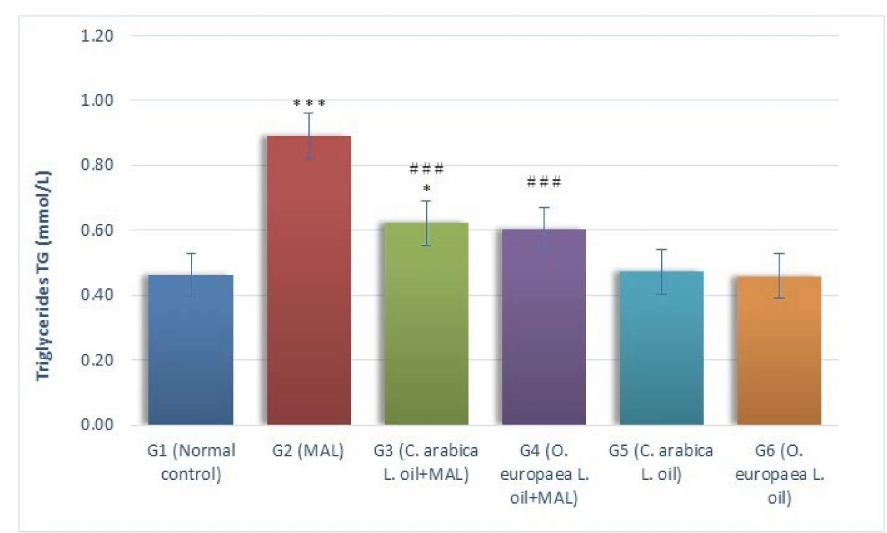
Figure 1. Influence of Coffea arabica L. oil and Olea europaea L. oil on the serum triglyceride levels. When a comparison was made against the normal control group, a significant difference was found in the mean values at p ≤ 0.05 *; p ≤ 0.001 ***. When a comparison was made against the MAL- intoxicated rats, a significant difference was found in the mean values at p ≤ 0.001 ### . The serum cholesterol (mmol/L) levels considerably ( p ≤ 0.001) increased as a result of MAL intoxication in the G2 group when a comparison was made with the G1 group of rats (normal control). Furthermore, while comparing it with the G1 group (normal control G1), the serum cholesterol levels considerably ( p ≤ 0.001) increased when the MAL-poisoned rats were daily fed with the oils of Coffea arabica L. (G3) and Olea europaea L. (G4) in the measures of 400 mg/kg BW, alternatively, as compared to the MAL-intoxicated G2 rats, the serum levels of cholesterol significantly decreased in MAL-poisoned rats when fed with the oils of Coffea arabica L. (G3: p ≤ 0.01) and Olea europaea L. (G4: p ≤ 0.001), as shown in Figure 2.